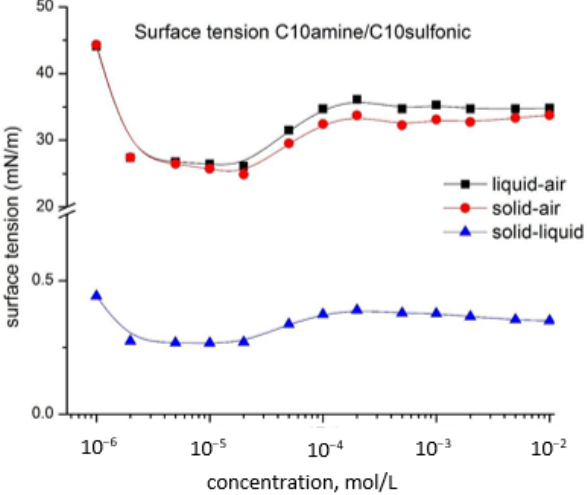
Figure 9. Surface tension of C10 amine/C10sulfonate solution for different interfaces.